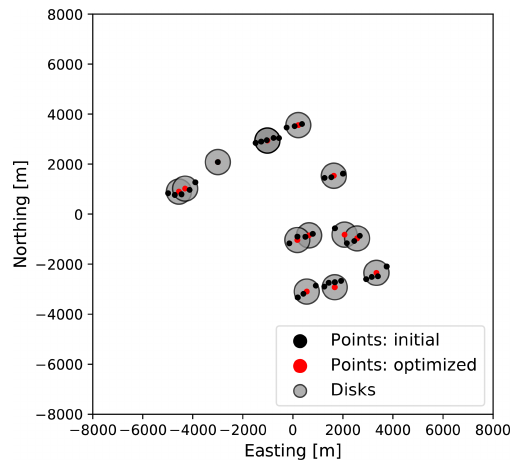
Figure 10. Measurement locations for Italian site: black dots – wind turbine positions, gray circles – disks covering wind turbine positions, red dots – optimized measurement positions (i.e., disk